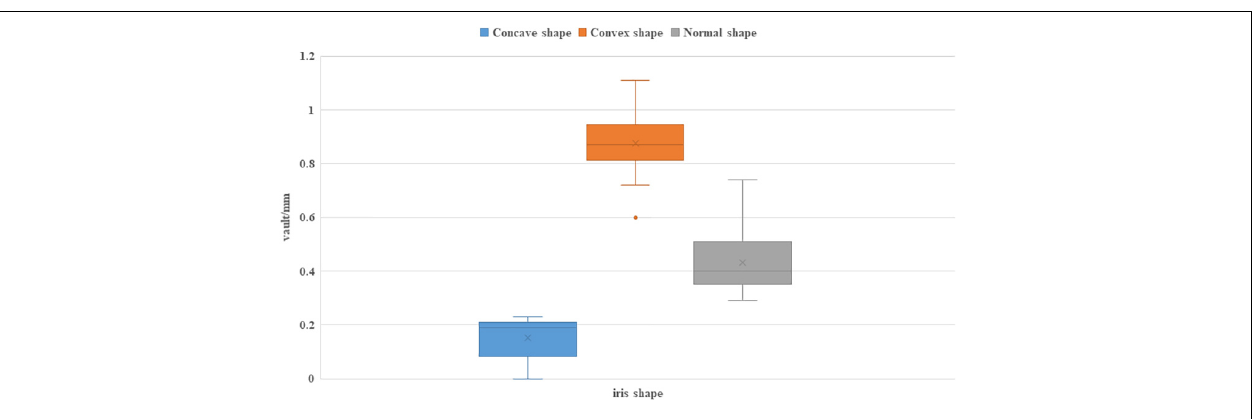
Frontiers in Medicine |